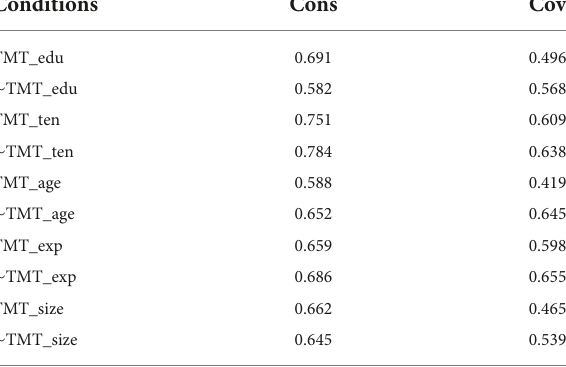
TABLE 4 Overview of necessary conditions for